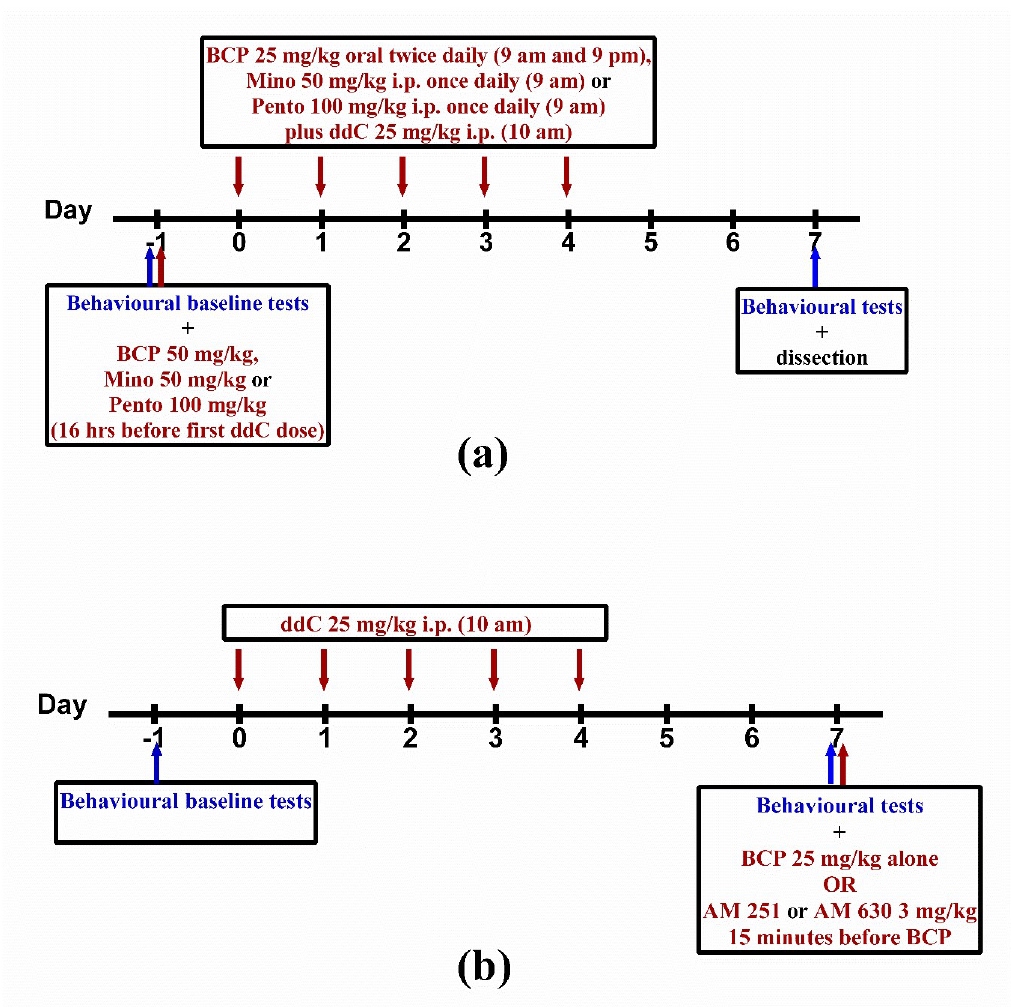
Figure 7. ( a ) Drug administration schedule for preventative treatment with β-caryophyllene (BCP), minocycline (Mino) or pentoxifylline (Pento) against 2′-3′-dideoxycytidine (ddC)-induced neuropathy. ( b ) Drug administration schedule for treatment with BCP against established ddC-induced neuropathy and for the CB receptor antagonists AM 251 and AM 630 before BCP. The maroon arrows indicate the days when the drugs were administered, while the blue arrows indicate when the behavioral tests were performed.